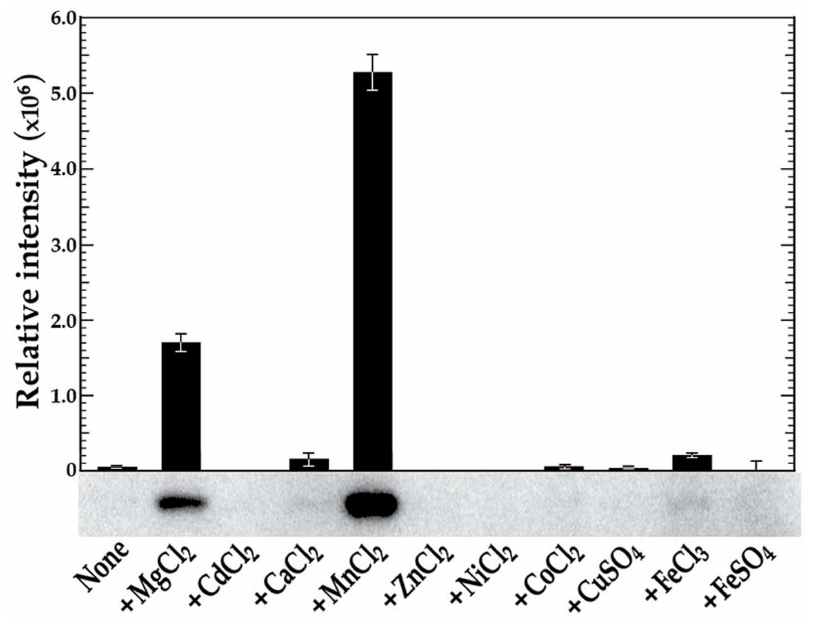
Fig. 1. in vitro phosphorylation of VicK in the presence of various metal cations. VicK (1 m M) was incubated in 100 mM Tris-HCl, pH 7.5 containing 1 mM of the designated cations and 0.10 m M [ c - 32 P] ATP at room temperature for 15 minutes. The relative autophosphorylation of VicK was quantified using Image Quant 5.0 software (Molecular Dynamics) and is represented by the histogram above the scanned gel. The gels shown are representative of at least three independent experiments. Error bars represent ¡ std. errors of the average phosphorylation values derived from at least 3 independent experiments.